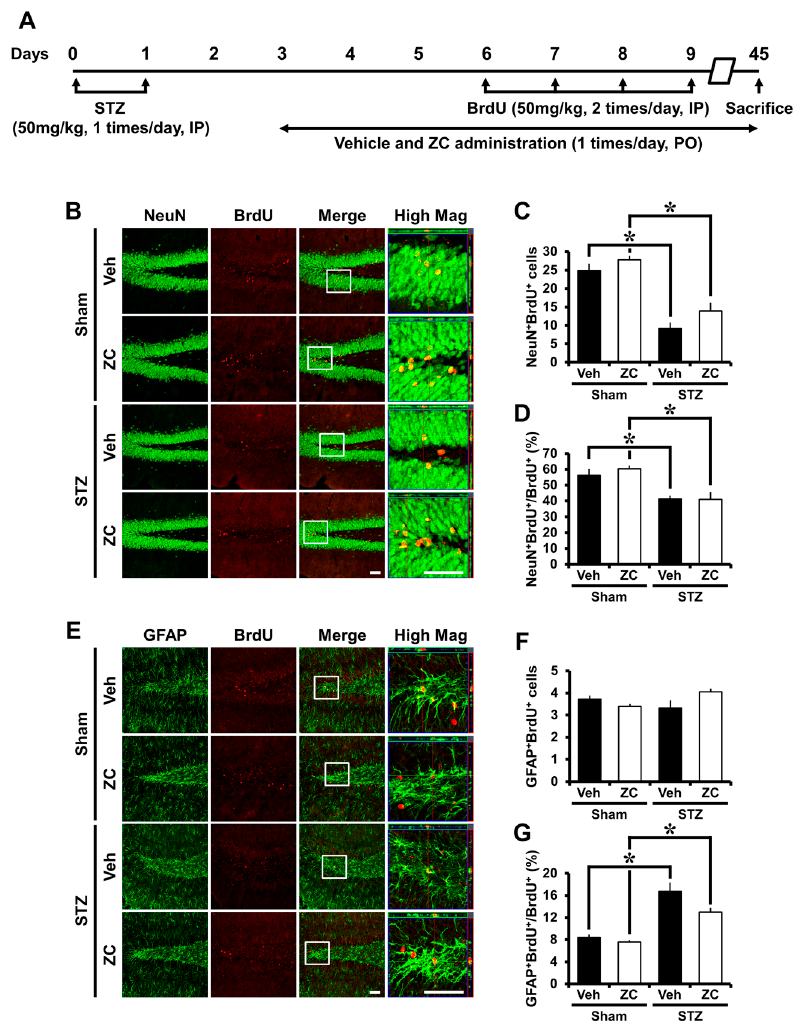
Figure 5. ZC does not affect neurogenesis in the late phase of STZ-induced diabetic rats. ( A ) Experimental procedure in the late phase of STZ-induced diabetic rats; ( B ) Representative images show double-labeling immunofluorescence of BrdU and NeuN positive cells in the hippocampal DG. STZ-injected group showed a significant decrease of BrdU + /NeuN + cells. ZC treatment by gavage for six weeks after STZ-induced hyperglycemia showed no difference in the number of BrdU + /NeuN + cells. Scale bar = 100 µm; ( C ) Bar graph represents the number of BrdU + /NeuN + cells in the SGZ/GCL; ( D ) Bar graph show the proportion of BrdU + /NeuN + cells in BrdU + cells of the SGZ/GCL. Data are means ± SE, n = 5–8 from each group. * p < 0.05, versus sham group; ( E ) Representative images show double-labeling immunofluorescence of BrdU and GFAP positive cells in the hippocampal DG. There were no differences among the groups in the number of BrdU + /GFAP + cells. Scale bar = 100 µm; ( F ) Bar graph represents the number of BrdU + /GFAP + cells in the SGZ/GCL; ( G ) Bar graph show the proportion of BrdU + /GFAP + cells in BrdU + cells of the SGZ/GCL. Data are means ± SE, n = 5–8 from each group. * p < 0.05, versus sham group.